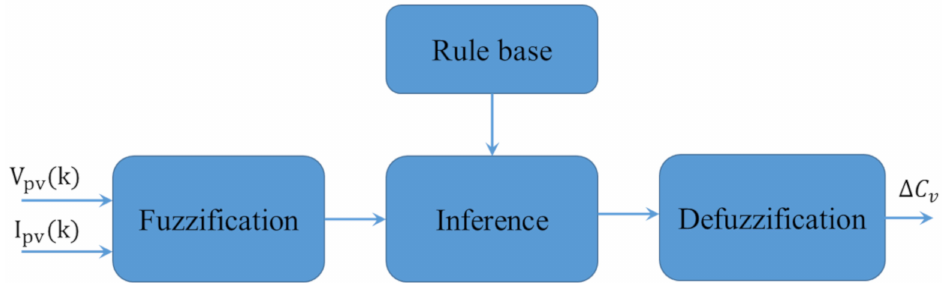
Figure 12. Variable step using Fuzzy control